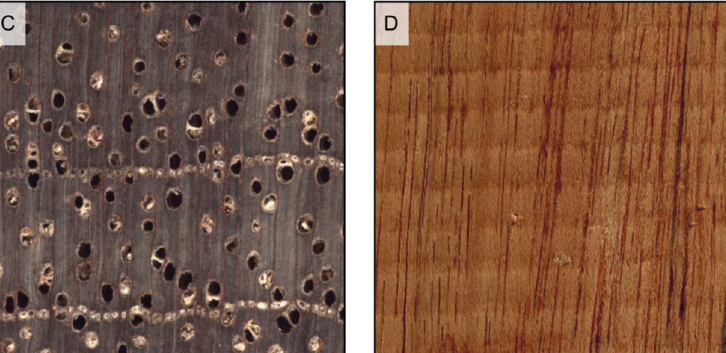
Figure 18. Axial canals in hardwoods (all transverse sections except D ). ( A ) axial canals diffuse ( Daniellia ogea ); ( B ) axial canals in short tangential lines ( Dipterocarpus alatus); ( C ) axial canals in long tangential lines ( Shorea acuminata ); ( D ) streaks on a longitudinal surface determined by axial canals ( Prioria sp.).